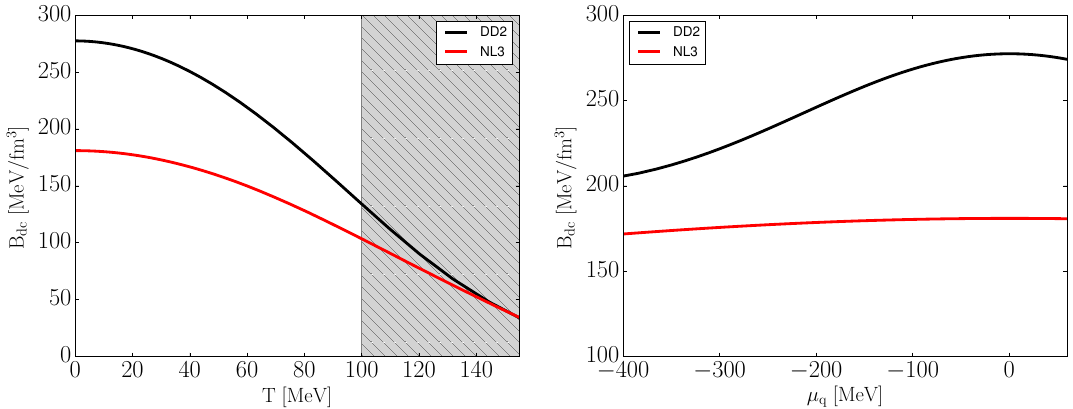
Figure 4. The deconfinement bag constant B dc (Equation (31)) as a function of temperature for µ c = 0 ( left ) and the charge chemical potential for T = 0 ( right ). The grey region lies outside of the models expected applicability domain. See text for